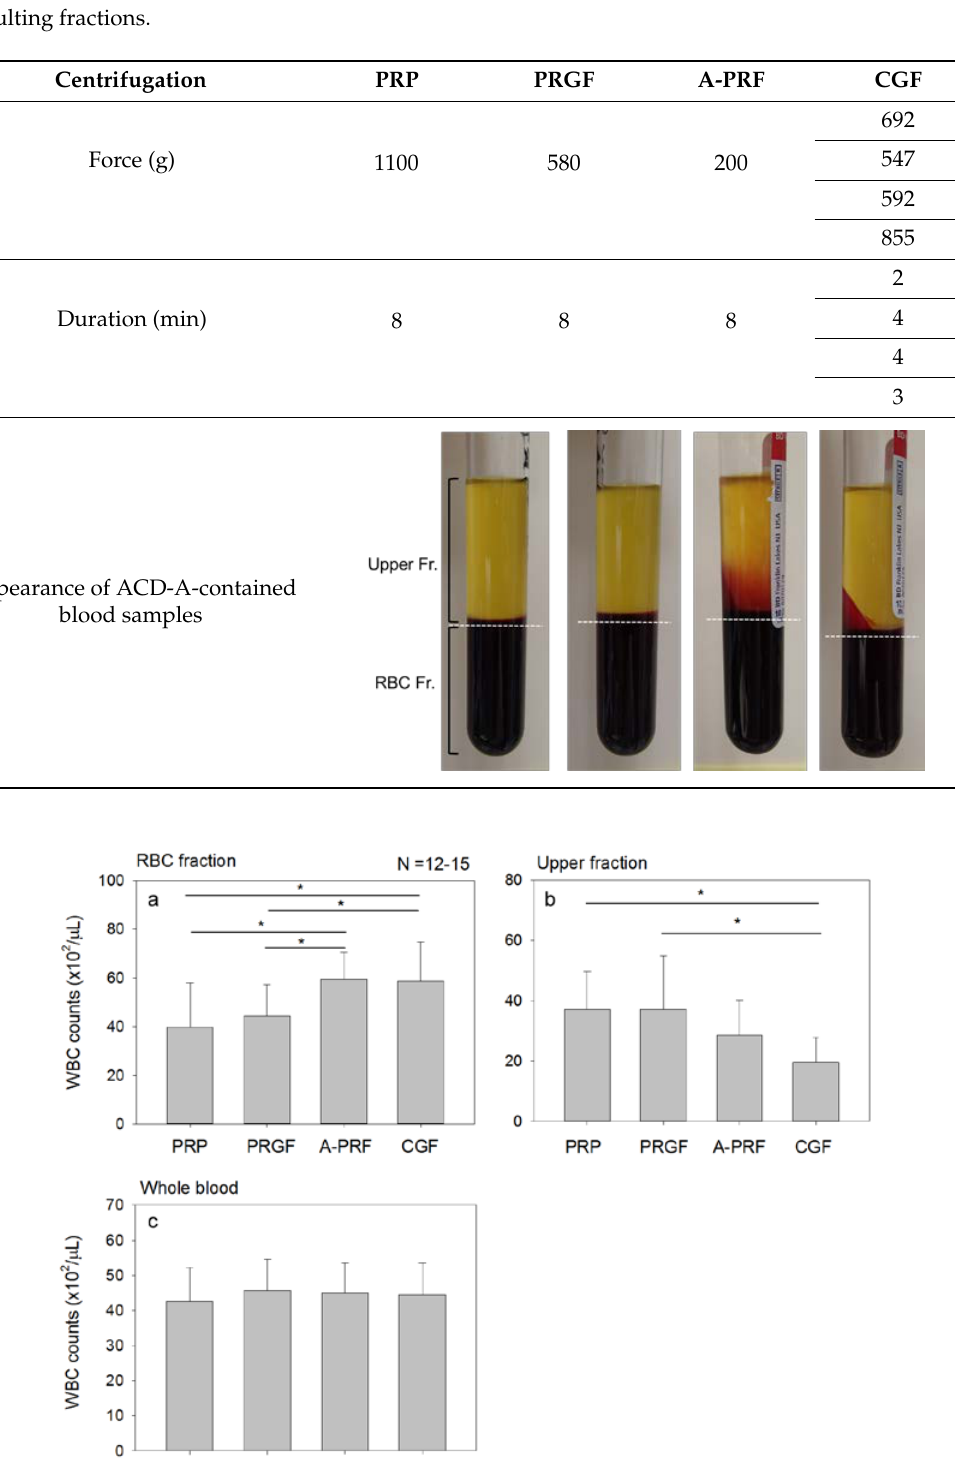
Figure 1. WBC counts in the RBC fraction ( a ), upper plasma fraction ( b ), and whole blood sample ( c ). Peripheral blood samples were collected in the presence of the anti-coagulant and centrifuged by the individual centrifugation protocols. The upper fraction was collected above the line indicated in Table 1. The remainder of the fractionated sample was used as the RBC fraction. N = 12–15. The asterisks represent statistically significant difference ( p < 0.05). Platelet distributions in the fractionated samples are shown in Figure 2. Whole blood samples were fractionated as in Table 1. Platelet counts in the RBC fraction were relatively lower in the PRGF- simulation model. Instead, those in the upper fraction were significantly higher in both the PRGF- and the A-PRF-simulation models than that of the PRP- and CGF-simulation models. Both the PRGF- and A-PRF-simulation models adopted relatively low-speed centrifugation.